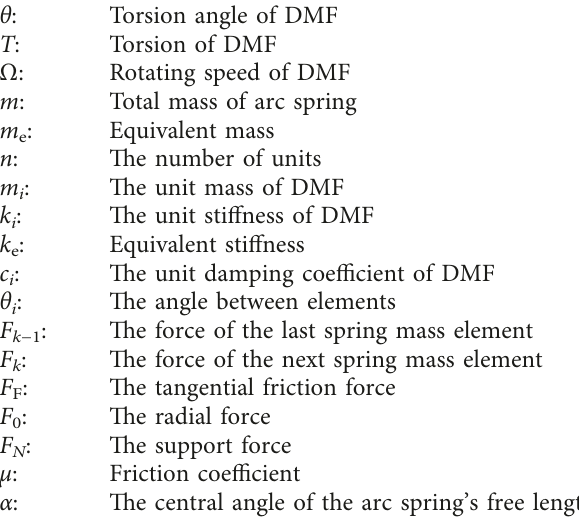
° . (a) Dynamic stiffness k 0 (cid:31) 5